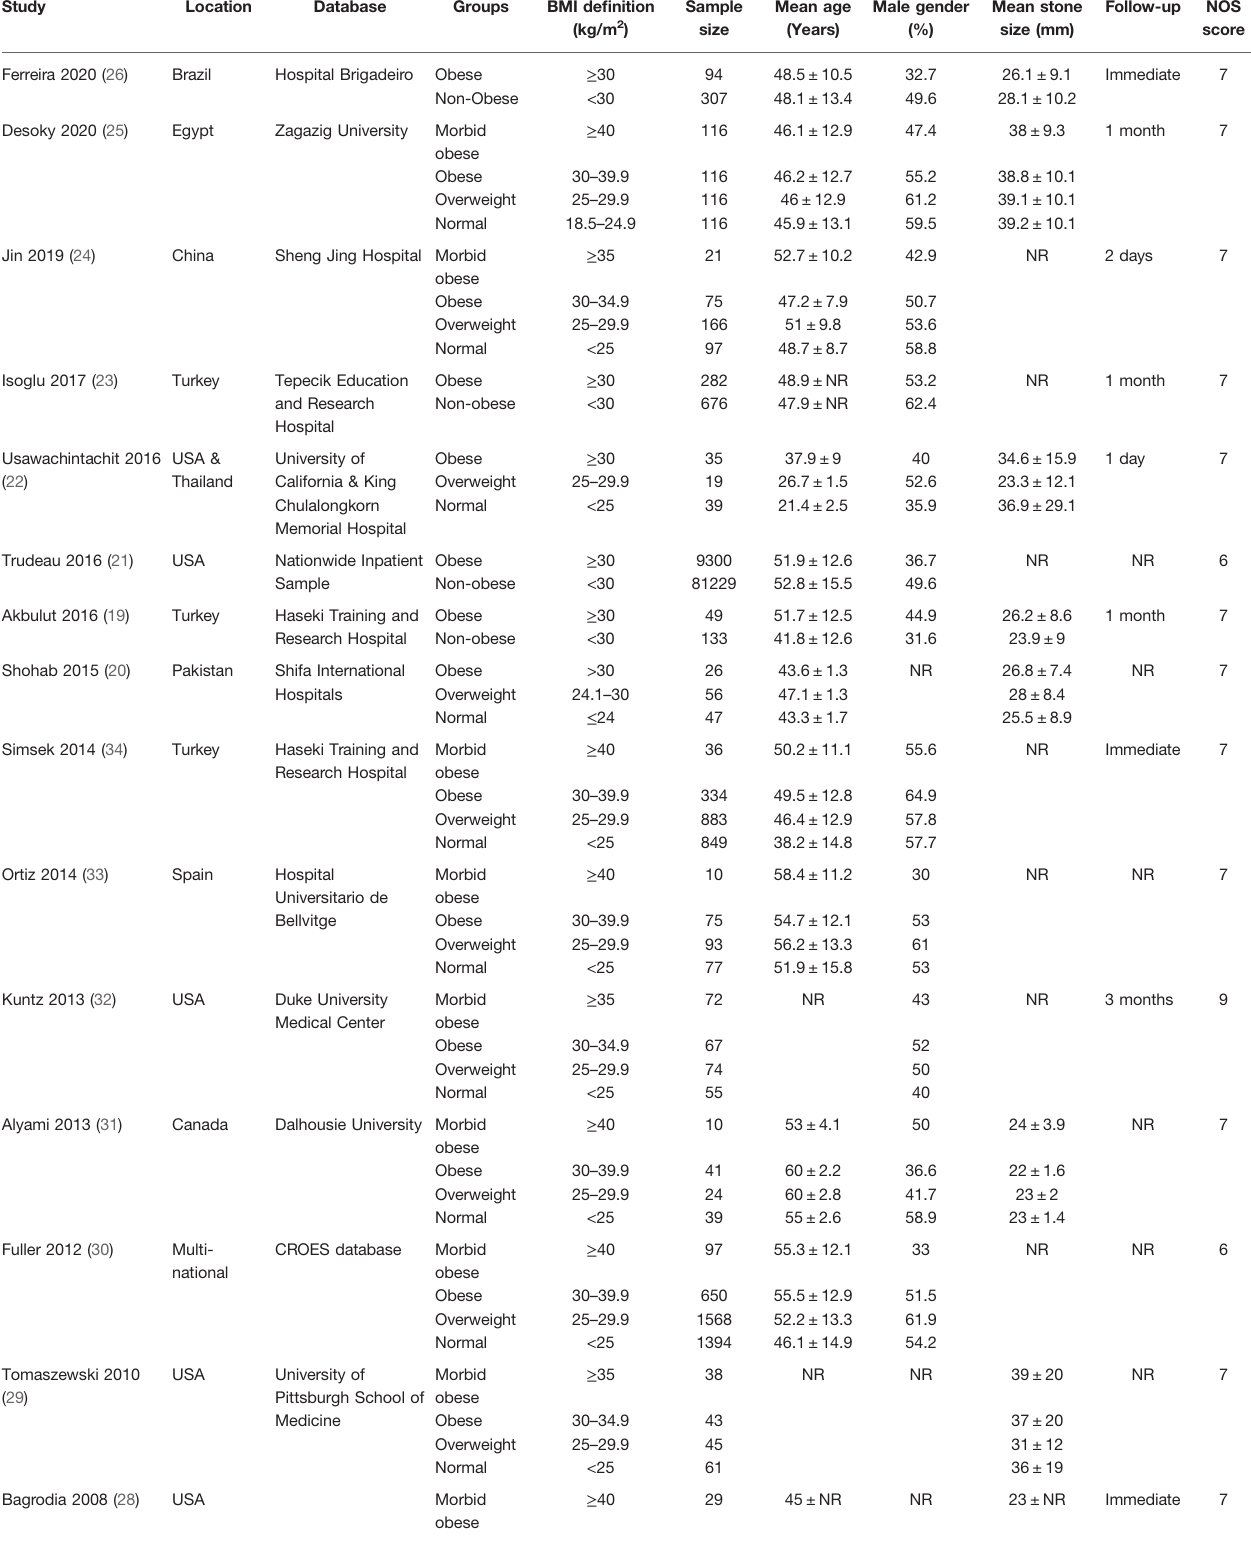
TABLE 2 | Details of included